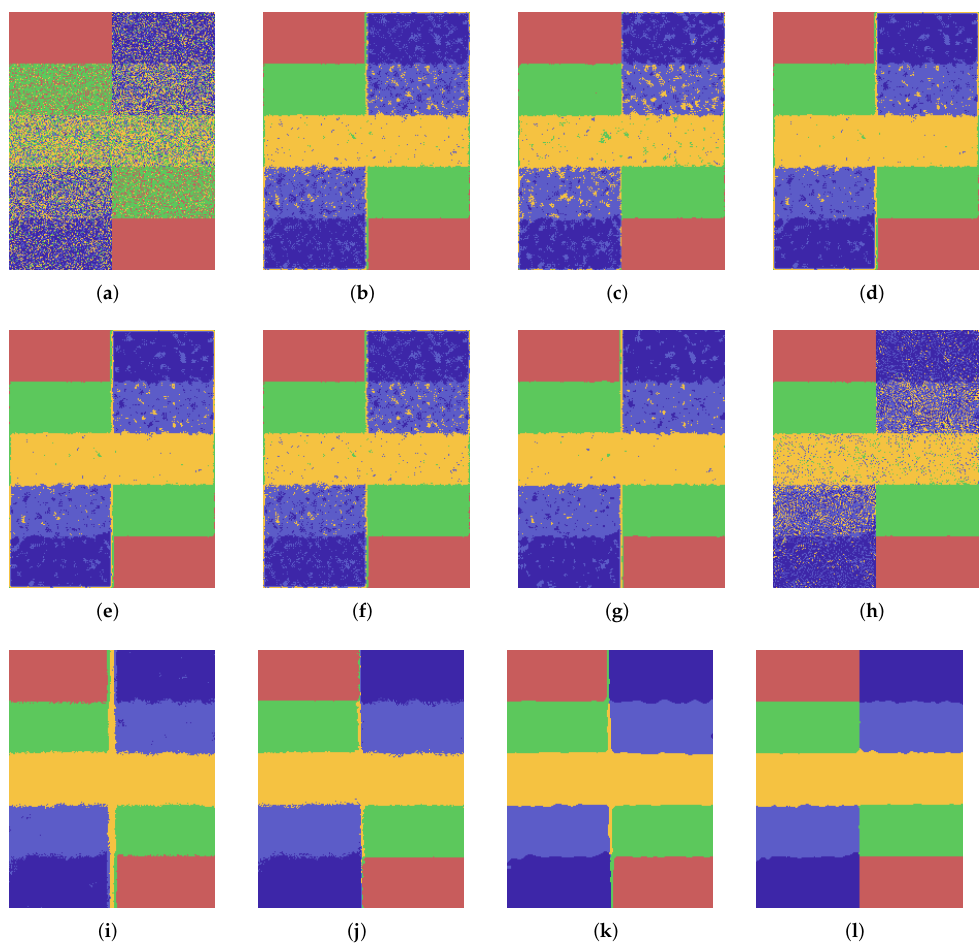
Figure 7. The segmentation results on simulated SAR image. ( a ) FCM. ( b ) FCM_S1. ( c ) FCM_S2. ( d ) KFCM_S1. ( e ) KFCM_S2. ( f ) EnFCM. ( g ) FGFCM. ( h ) FCM_NLS. ( i ) NS_FCM. ( j ) RFCM_BNL. ( k ) LBNL_FCM. ( l ) GLR_FCM.